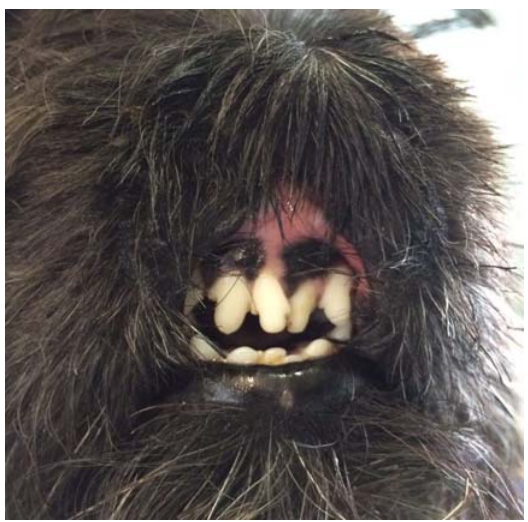
Figure 3. Frontal view of the muzzle five months after the removal of stents.